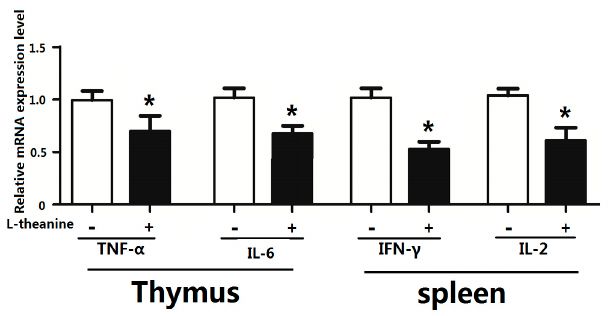
Figure 5. Effects of L -theanine on relative mRNA expression of cytokines in immune tissue. Note: Values are means ± SEM. vs. control group, * p ≤ 0.05.